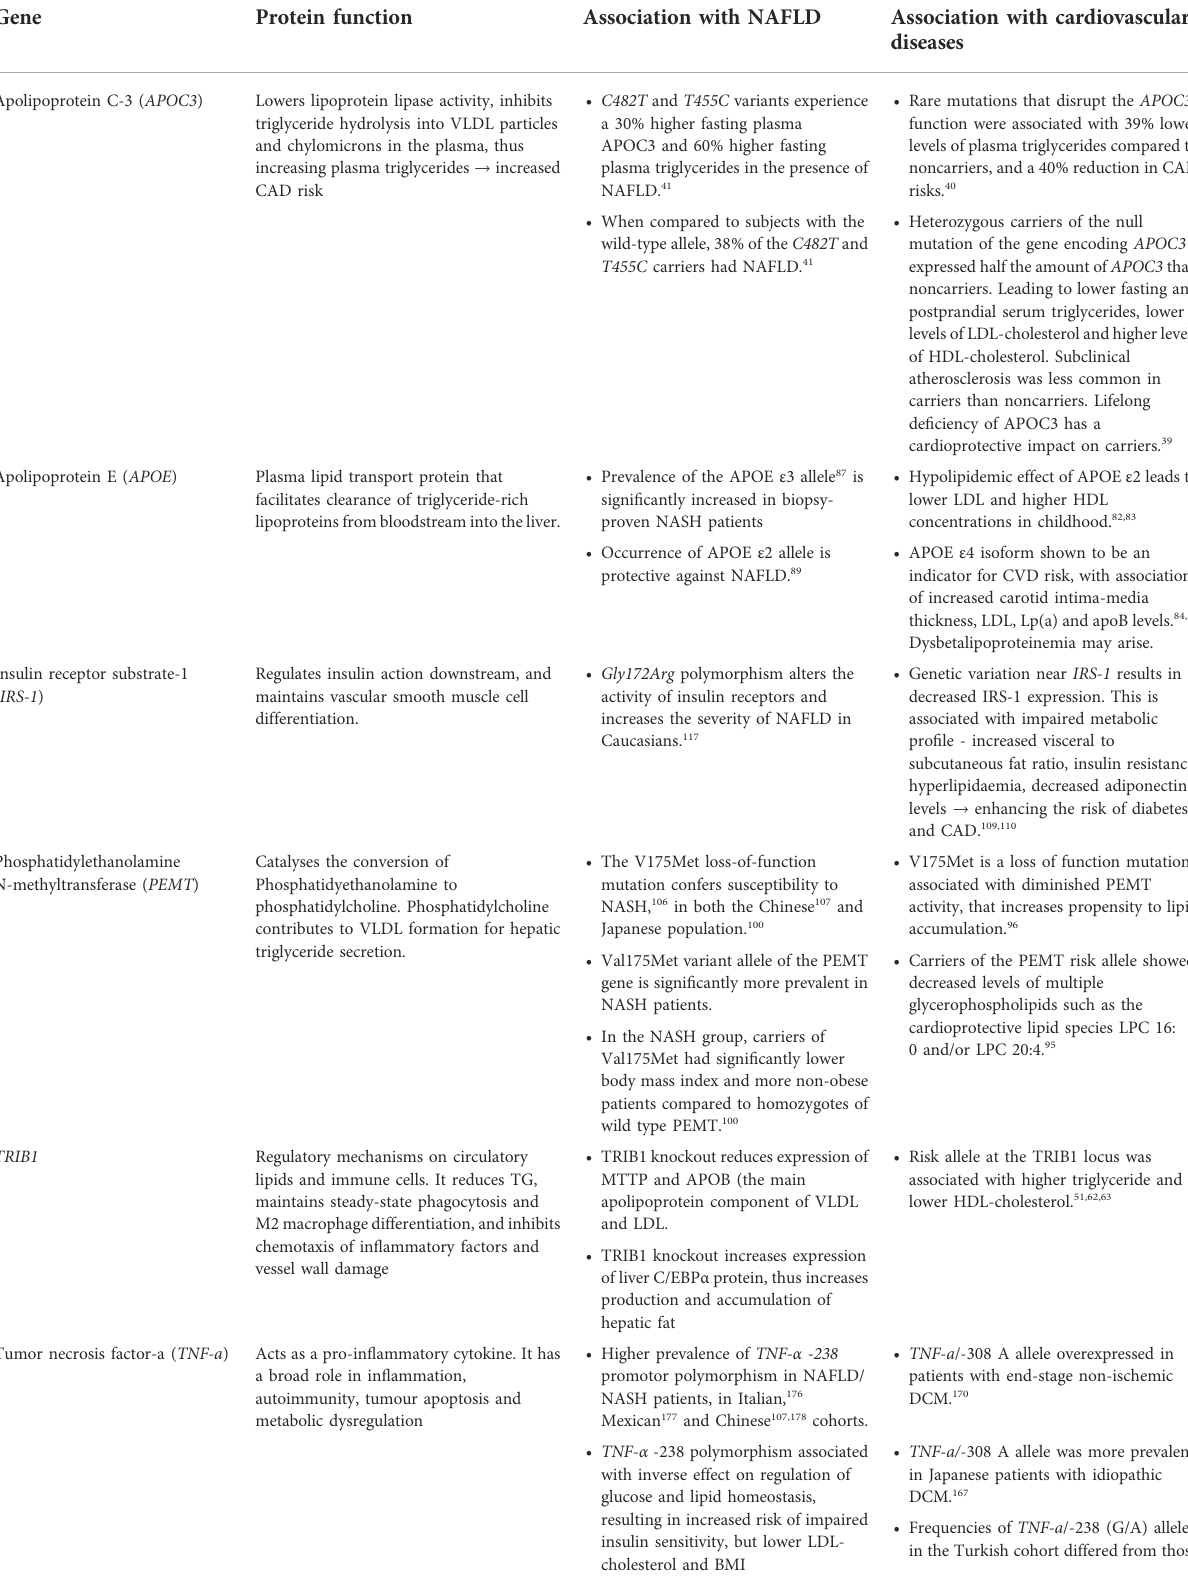
TABLE 1 Summary of genomic variants identi fi ed in both NAFLD and